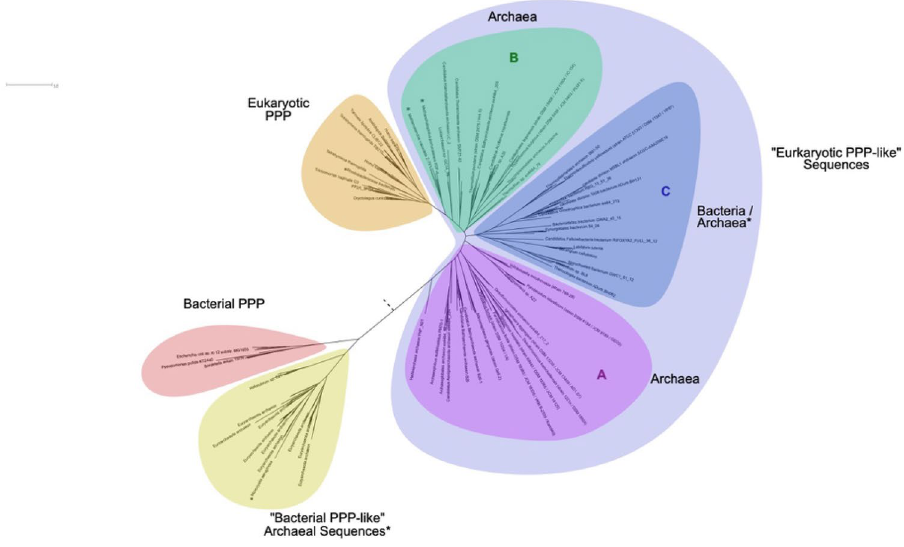
Figure 3. Evolution of PPP sequences in Archaea, Bacteria and Eukaryotes—radial phylogenetic tree. Candidate PPP sequences were collected by Hidden Markov Model (HMM) based search methods, aligned,